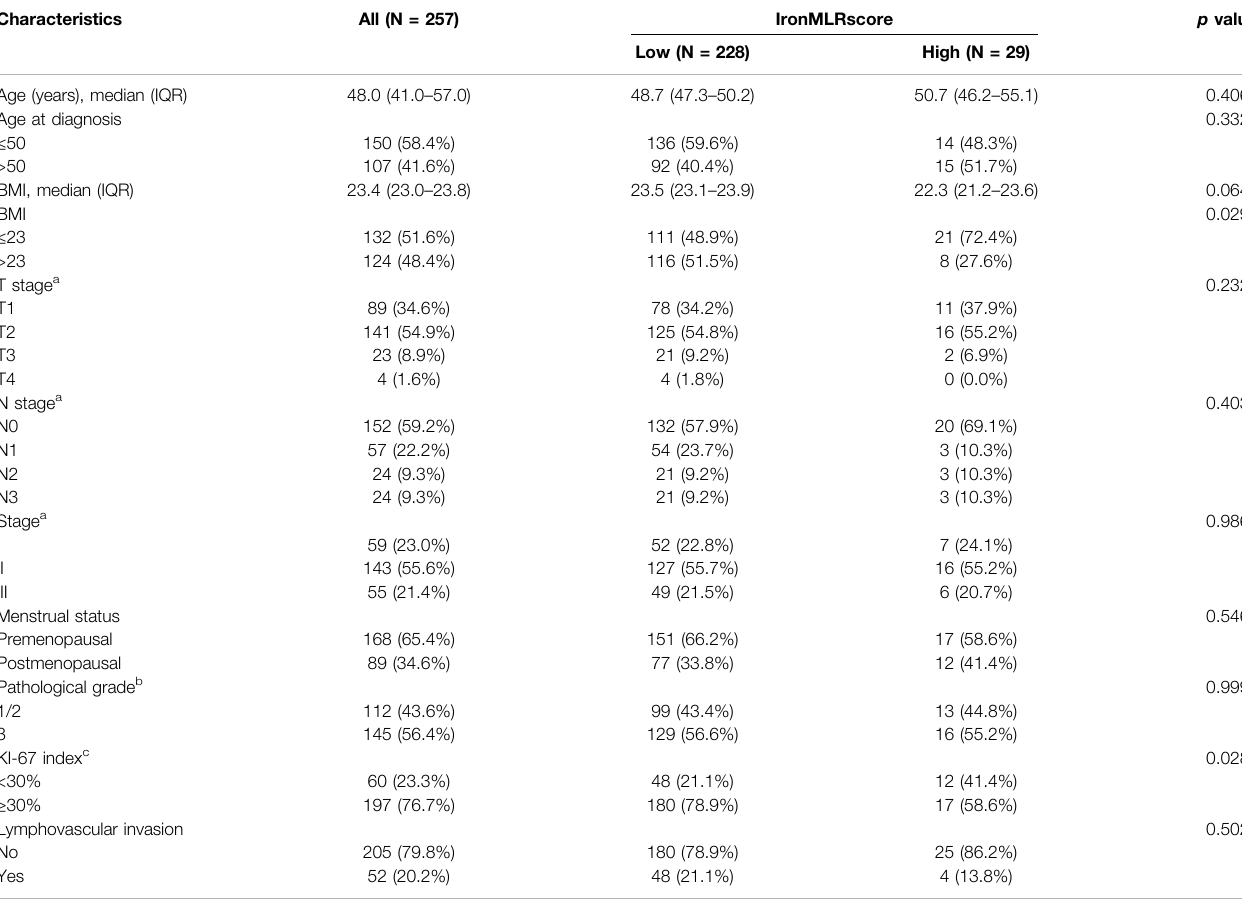
TABLE 1 | Characteristics of patients eligible in this study.